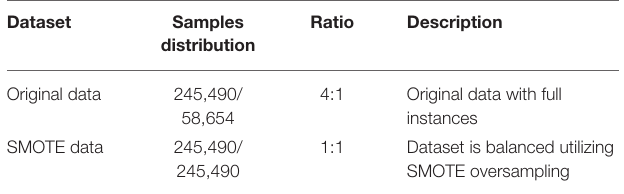
TABLE 2 | Dataset